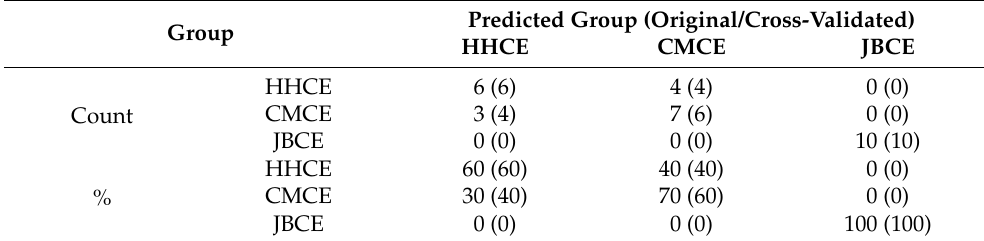
Table 4. Linear discriminant analysis of Coilia nasus populations in the Yellow Sea (HHCE), the Changjiang estuary (CMCE), and the Qiantang estuary (JBCE) based on δ 13 C, δ 18 O, and elemental ratio characteristics in the otolith nucleus region.